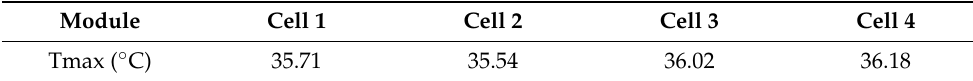
Table 3. Maximum temperature of the LiC cells within the